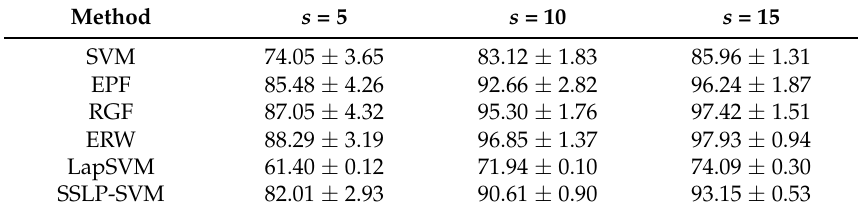
Table 4. Overall accuracy of the various methods for the Kennedy Space Center image (average of 10 runs with thestandard deviation; the bold values indicate the greatest accuracy among the method in each case).